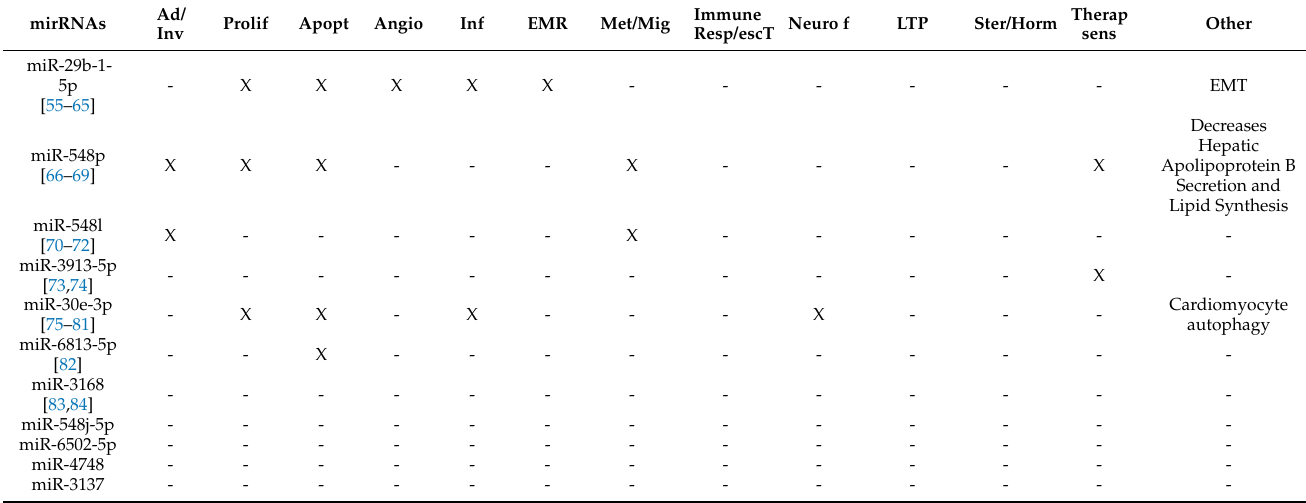
Table 3. miRNA-associated pathophysiologic pathways.